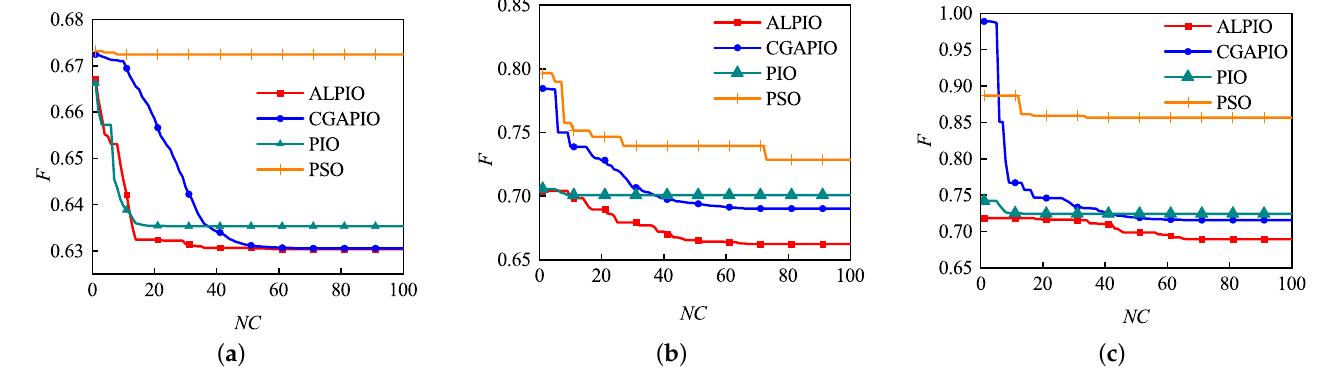
Figure 12. ( a ) Fitness value of different algorithms for completing path planning with four impulses; ( b ) fitness value of different algorithms for completing path planning with five impulses; ( c ) fitness value of different algorithms for completing path planning with six